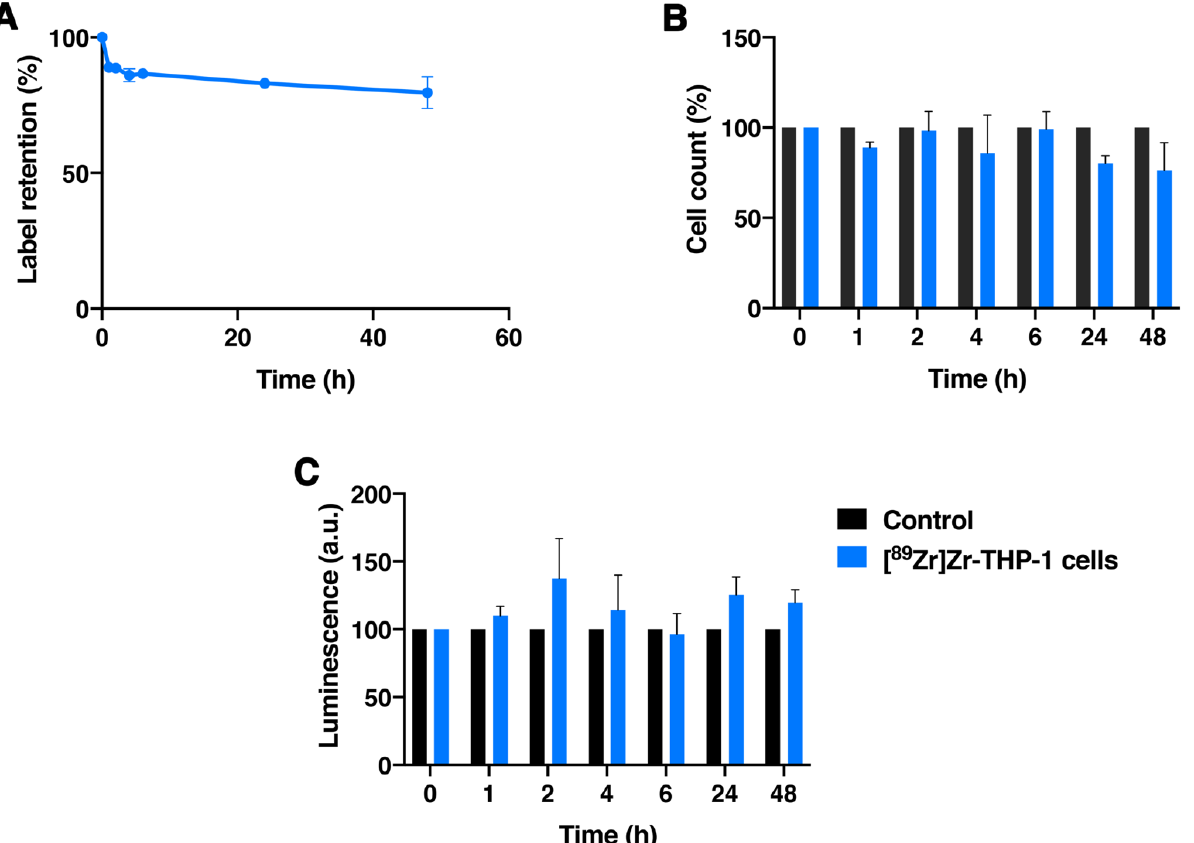
Figure 4. THP-1 labeling and retention of radionuclide over time. The 89 Zr-retention by THP-1 cells was measured for 1, 2, 4, 6, 24 and 48 h, at culture conditions; ( A ) the cells were measured for relative radioactivity after one spin; ( B ) viable cell numbers counted with trypan blue staining; and ( C ) the ATP content of cells as a measure with CellTiter-Glo for cell viability. In all experiments, controls are THP-1 cells which were treated in the same way as other conditions without [89Zr]Zr-PLGA-NH2 but with PBS. Moreover, the controls did not change in value over time and therefore were set to 100%, and the remaining samples were compared to the controls. The mean and standard deviation of at least three independent experimental datasets are shown.